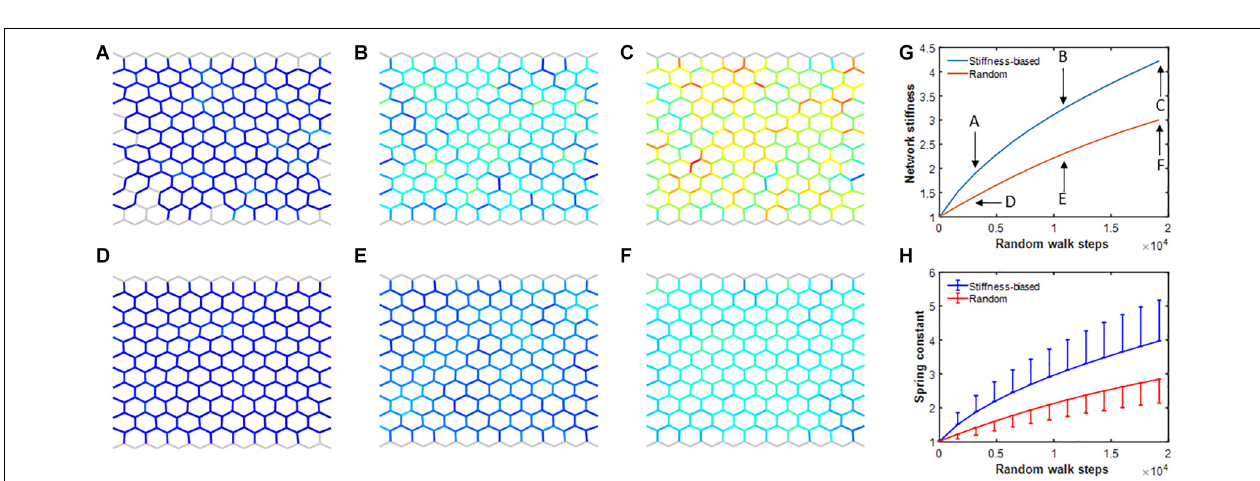
FIGURE 7 | (A–F) Network configurations during simulations using the self-healing model on the network while agent activity was set to 0 after every second iteration. Top (A–C) and bottom (D–F) rows show networks in which agent walk was stiffness biased or pure random, respectively. Gray network members have normal stiffness of ∼ 1. Colors from blue to red indicate increasingly stiffer springs. (G) Network stiffness as a function of iteration number which represents time for stiffness-biased (blue) and pure random (red) walks. (H) Mean and SD of spring stiffnesses for stiffness-biased (blue) and pure random (red)